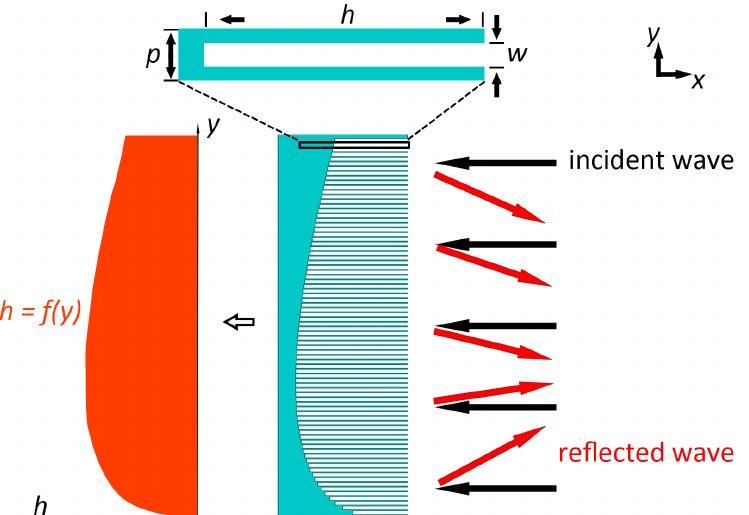
Figure 1. Illustration of the ultra broadband structure. Black arrows: incident waves; red arrows: reflected waves. Inset: zoom-in plot of a single tube within the structure. The depth profile of the tubes, h , is a function of the spatial location y . p = λ /8 is the period of the structure, and w = 0.8 p is the width of each